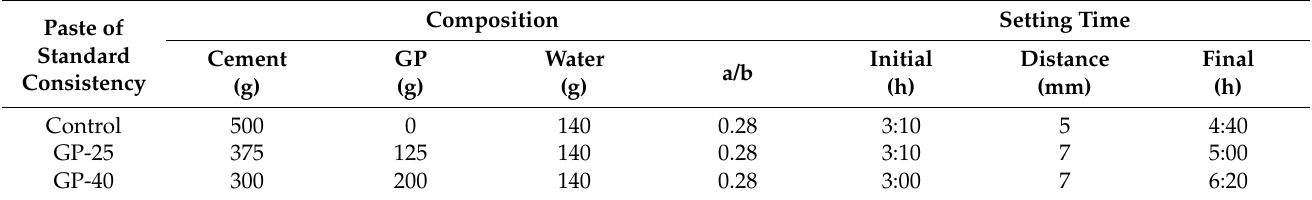
Table 6. Paste compositions and setting